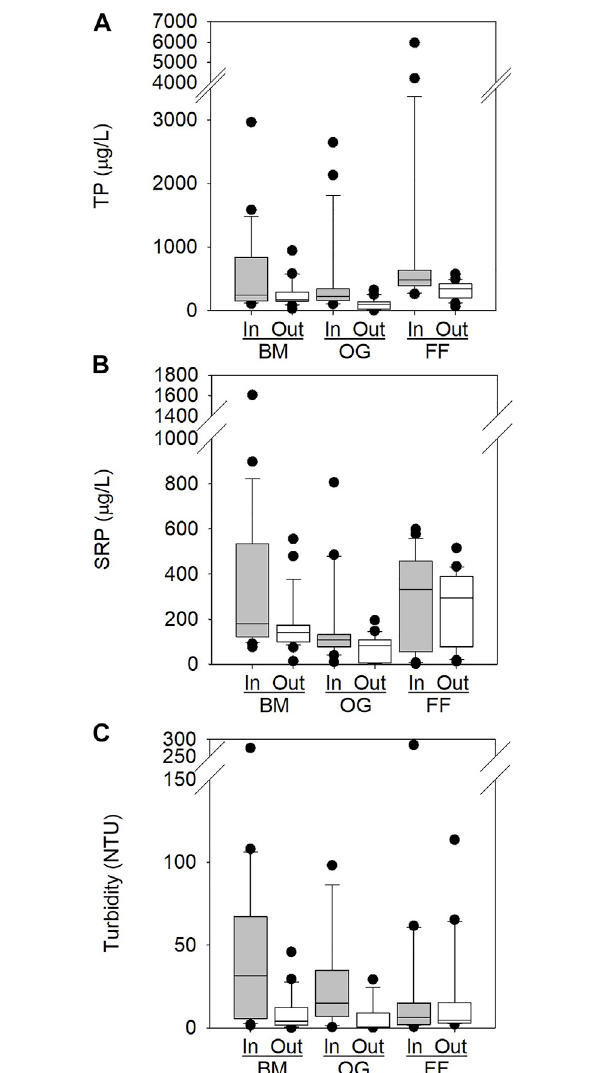
FIGURE 5 | Box and whisker plots showing distribution of (A) TP, (B) SRP,and (C) TurbidityofEAFslag fi lterin fl owsandout fl ows.Boxesrepresent upper quartile (75%), median (50%), and lower quartile (25%) of datasets. Whiskers indicate the maximum and minimum values of datasets excluding outliers, which are shown as